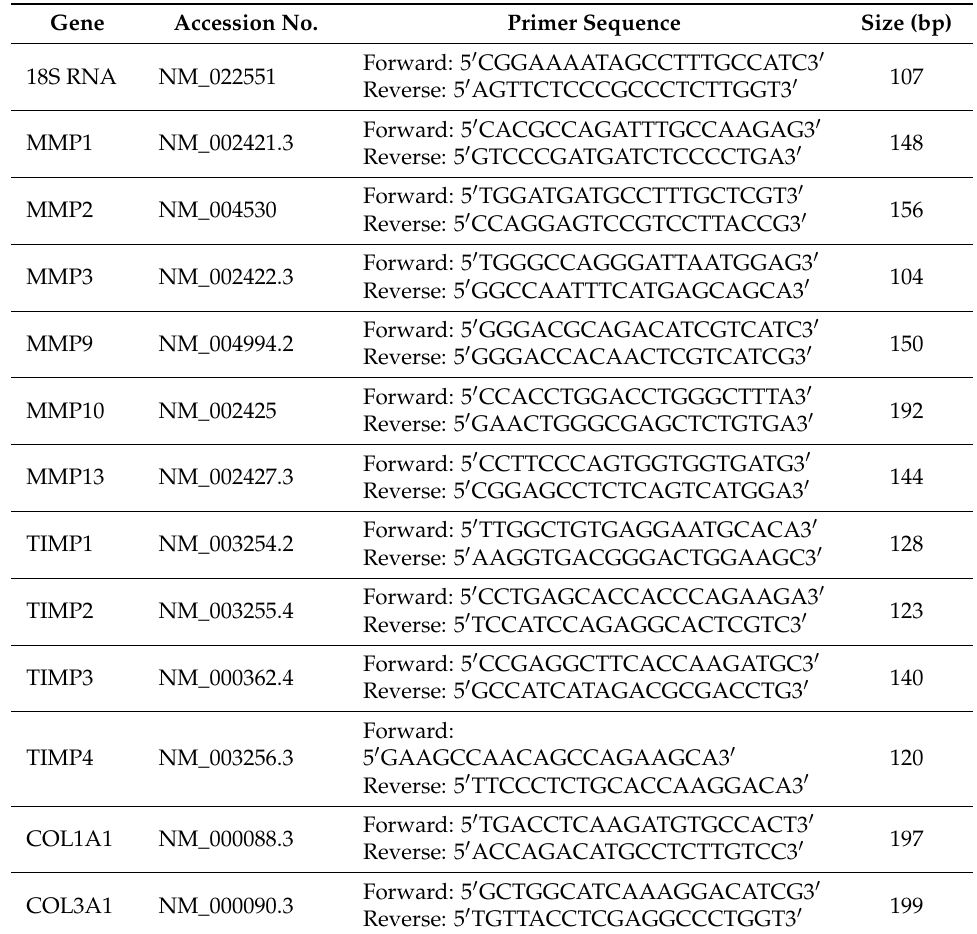
Table 3. qRT-PCR